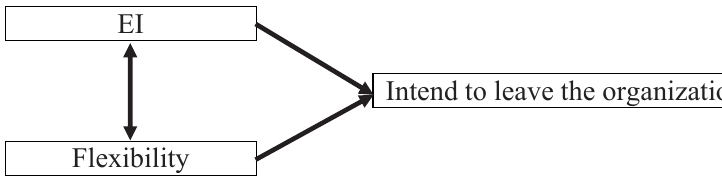
Fig. 1. The structure of the proposed study